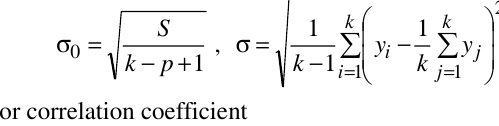
Fig 17. Finite element verification of response surfaces